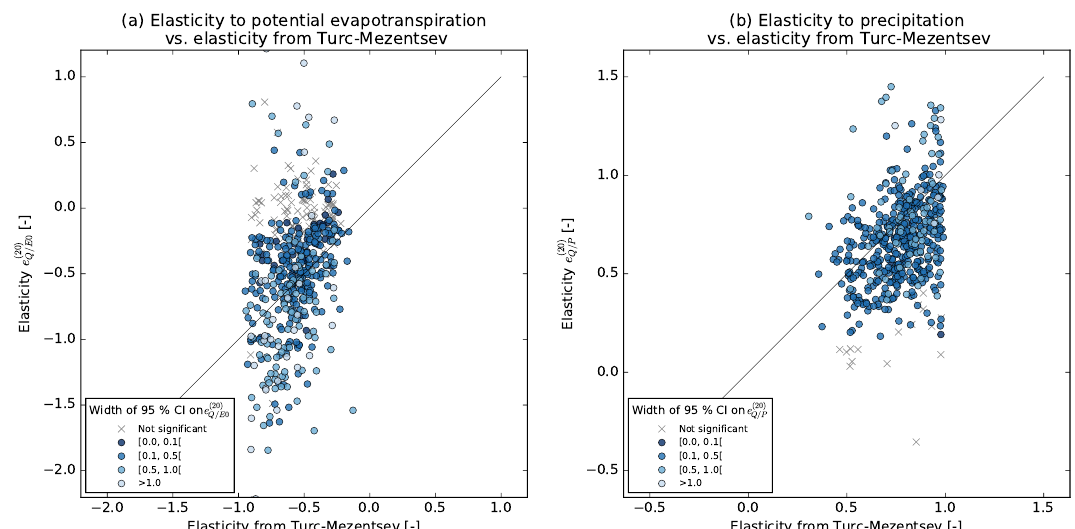
Figure 8. Comparison of the data-based and model-based elasticities; streamflow elasticity to potential evaporation (a) and precipitation (b) . The points are colored according to the width of the 95% bootstrap confidence intervals on the empirical elasticity estimate.